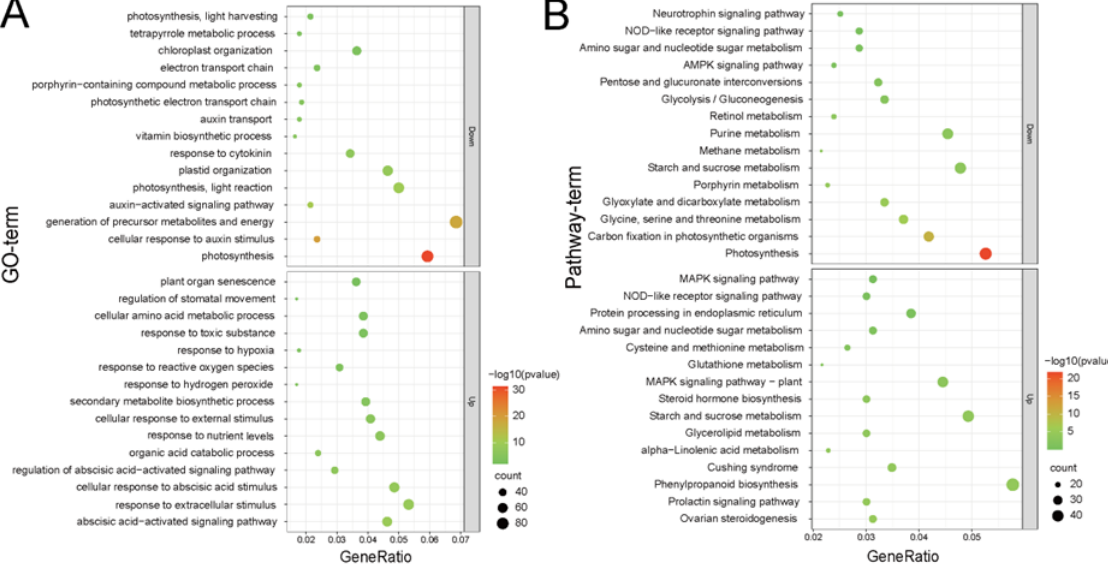
Figure 5. Gene enrichment of DEGs. ( A ) GO and ( B ) KEGG pathway enrichment analysis of upregulated DEGs and downregulated DEGs. Enrichment bubble plots were drawn by picking the top 15 terms for up- and downregulated DEGs.